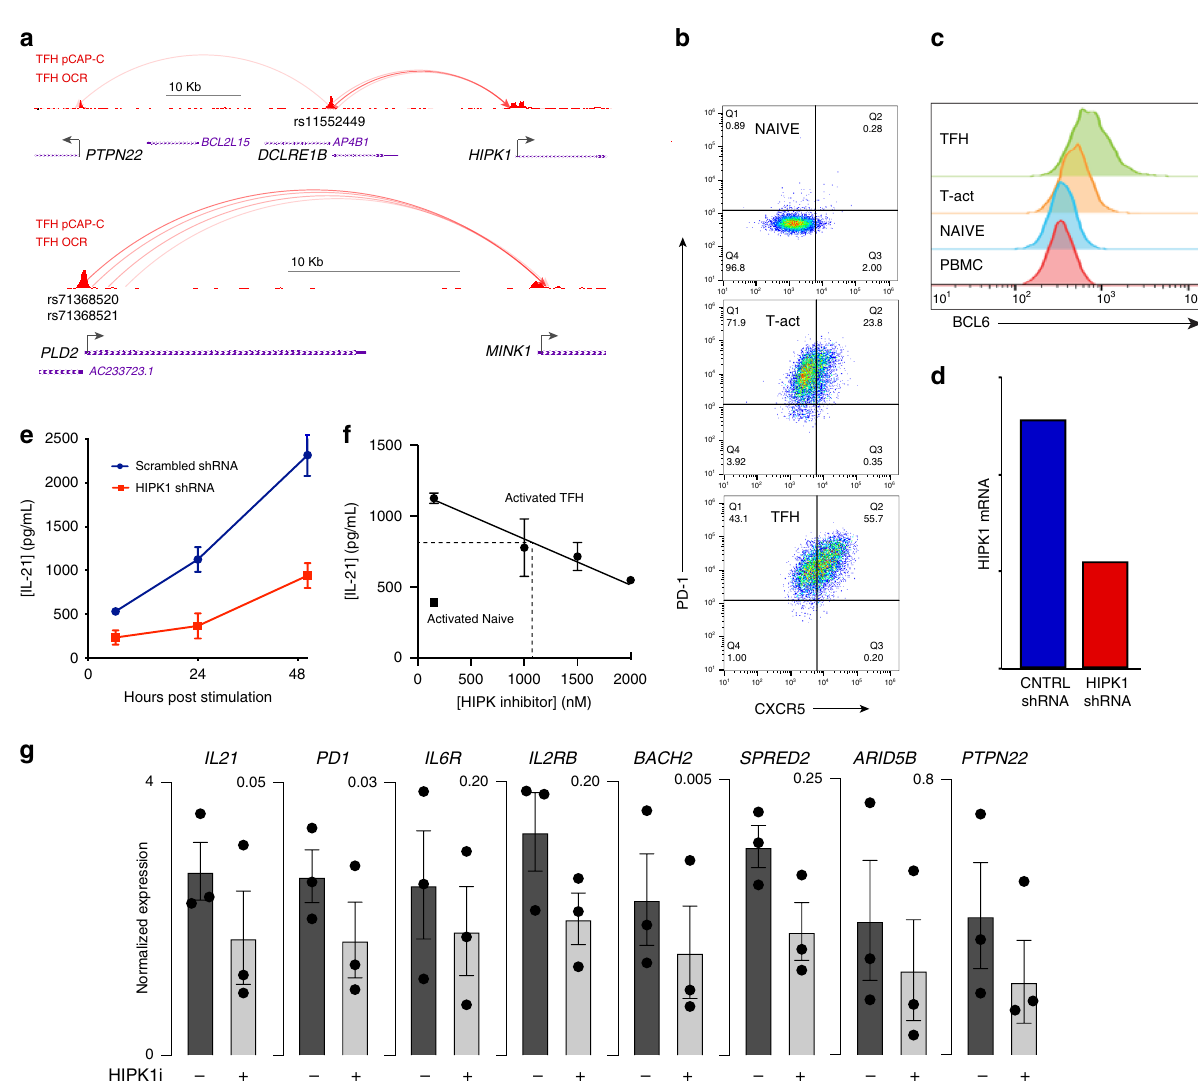
Fig. 9 SLE variant-to-gene mapping implicates drug targets for modulation of TFH function. a The interactomes of SLE proxies rs11552449 ( r 2 = 0.97), rs71368520 ( r 2 = 0.5), and rs71368521 ( r 2 = 0.5) implicate HIPK1 and MINK1. b Puri fi ed naive CD4 + T cells cultured under neutral (Tact) or TFH-skewing (TFH) conditions show increased expression of PD-1 and CXCR5, as well as BCL-6 ( c ). d HIPK1 mRNA expression by in vitro-differentiated TFH cells transduced with scrambled Lenti-shRNA or Lenti-HIPK-1 shRNA. e shRNA-mediated knock-down of HIPK1 inhibits IL-21 secretion by TFH cells. A HIPK inhibitory drug causes dose-dependent inhibition of IL-21 production ( f ) and expression of several SLE-associated gene ( g ) by TFH cells. All data in e and f are mean ± SEM and are representative of three independent experiments. Data in g depict the mean (columns) ± SEM (error bars) normalized gene expression by three individual donor T cell cultures (circles). Statistical signi fi cance of the effect of HIPK inhibition was determined by t -test (two-tailed). P values are: BACH2, 0.01; SPRED2, 0.02; IL2RB, 0.03; ARID5B, 0.03; PD1, 0.04; IL6R, 0.04; PTPN22, 0.05; IL21, 0.06. Source data are provided as a Source data fi